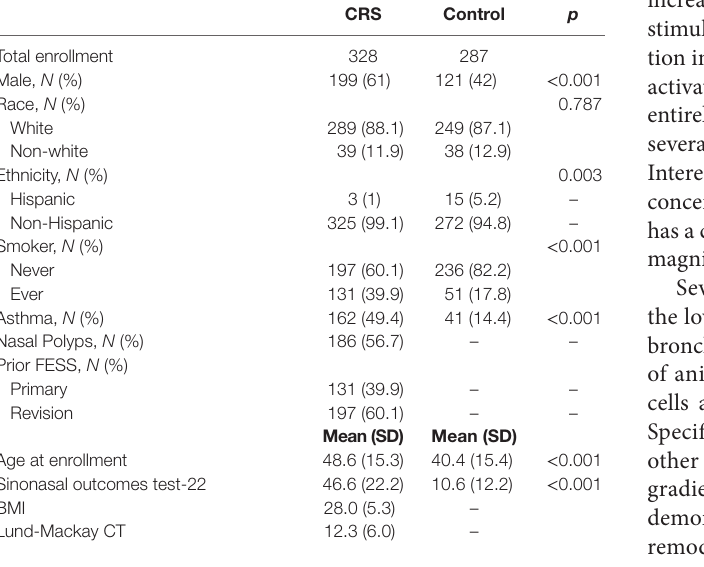
TaBle 1 | Demographic data for chronic rhinosinusitis (CRS) and control